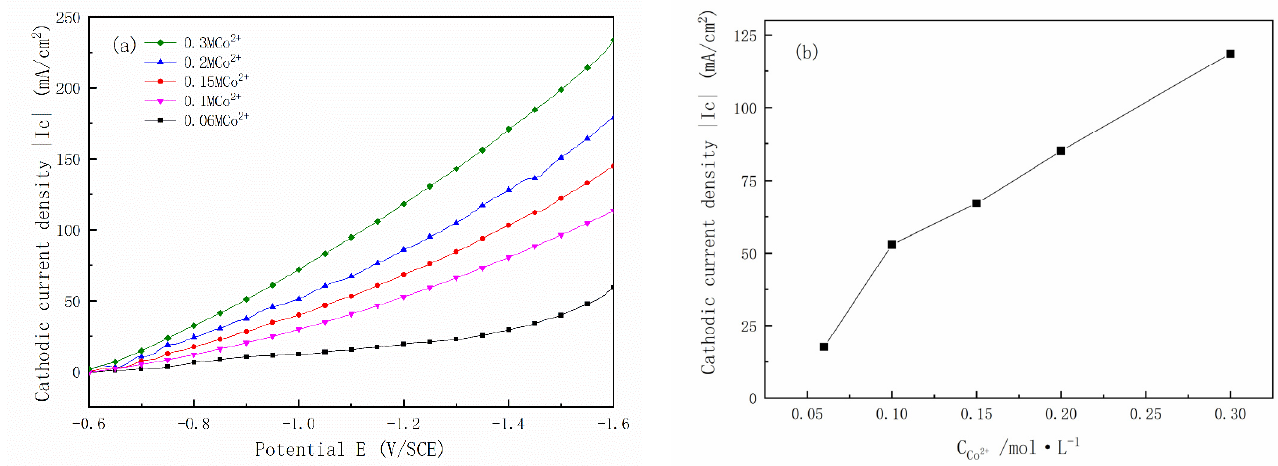
Figure 5. ( a ) Cathodic polarization curves measured in solutions with different Co 2+ concentrations; ( b ) the corresponding cathodic current density |Ic| at a potential of − 1.2 V.